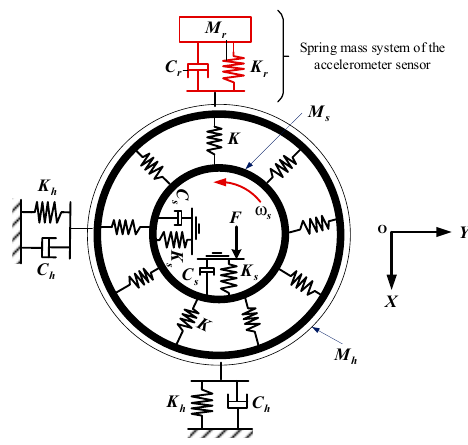
Figure 1 . Free-body diagram of a shaft-housing vibration system [18]. Figure 1. Free-body diagram of a shaft-housing vibration system